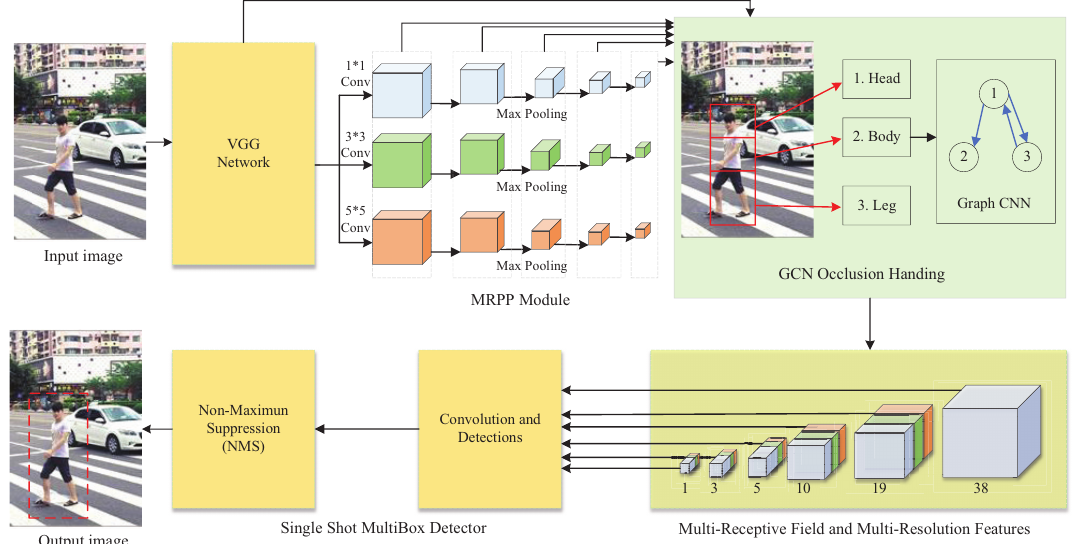
Figure 20. The framework of the pedestrian detection in